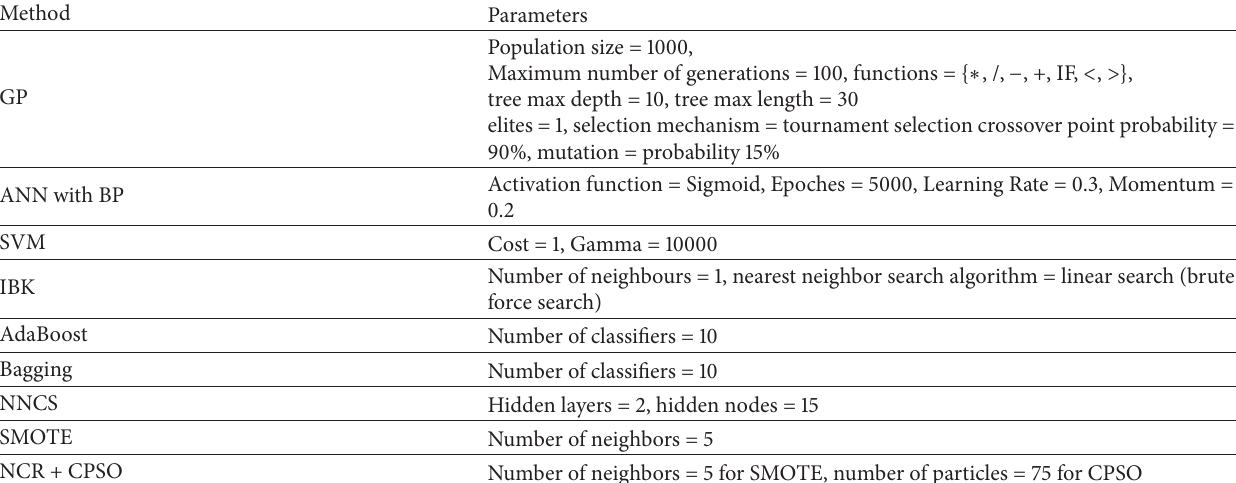
Table 5: Tuning parameters for data mining techniques used in the comparison study.